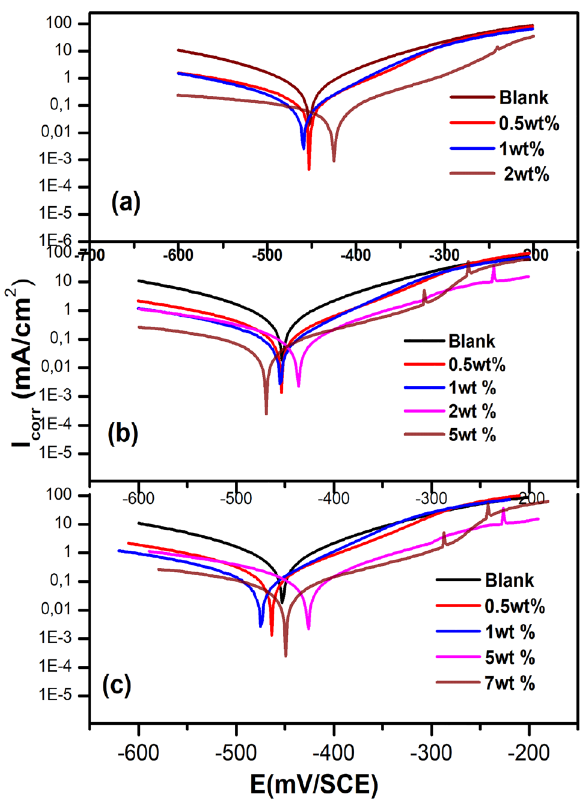
Figure 6. Polarization curves for steel 316L in 1 M HCl medium without and with Epoxy/Alumina coating at different concentrations of incorporated alumina corresponding to ( a ) Base metal zone, ( b ) Heat affected zone and ( c ) melted